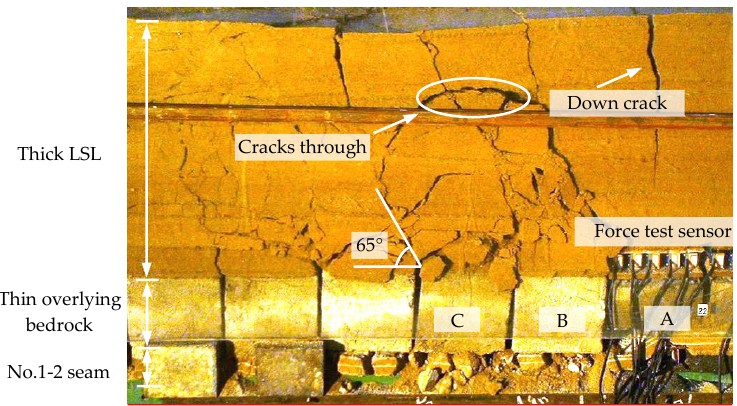
Figure 4. Periodic arc-shaped pillars and arching.